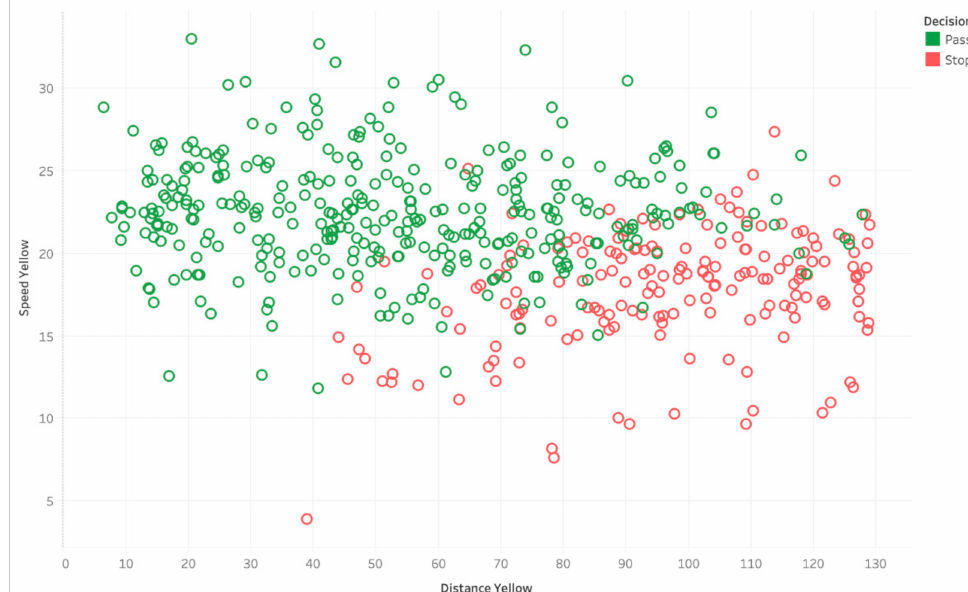
Figure 5. Correlation of driver’s decision with speed and distance from stop line.